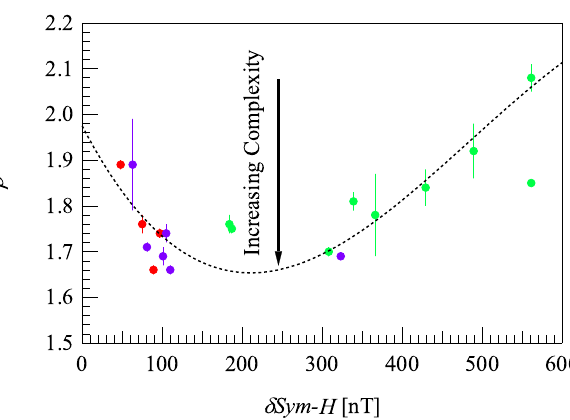
Fig. 4. Dependence of ρ on δ Sym-H (t) . Colors refer to different time intervals: red to pre-storm time intervals, green to storm time intervals, and purple to after-storm time